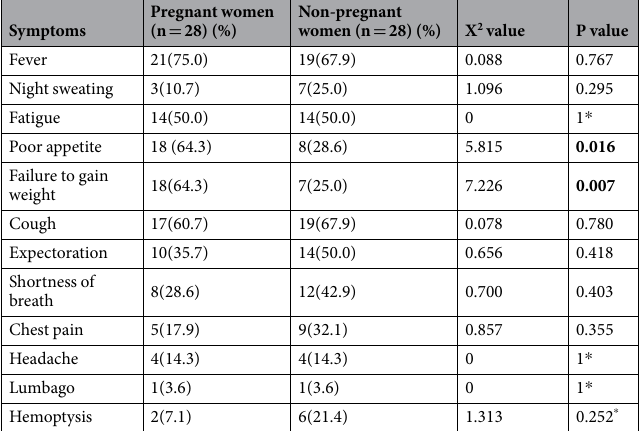
Table 3. Symptoms of TB in pregnant women and non-pregnant women. Categorical data was compared using the Chi-square test or Fisher’s exact test. Statistical significance set to P < 0.05 and was emphasized in bold. * Fisher’s exact